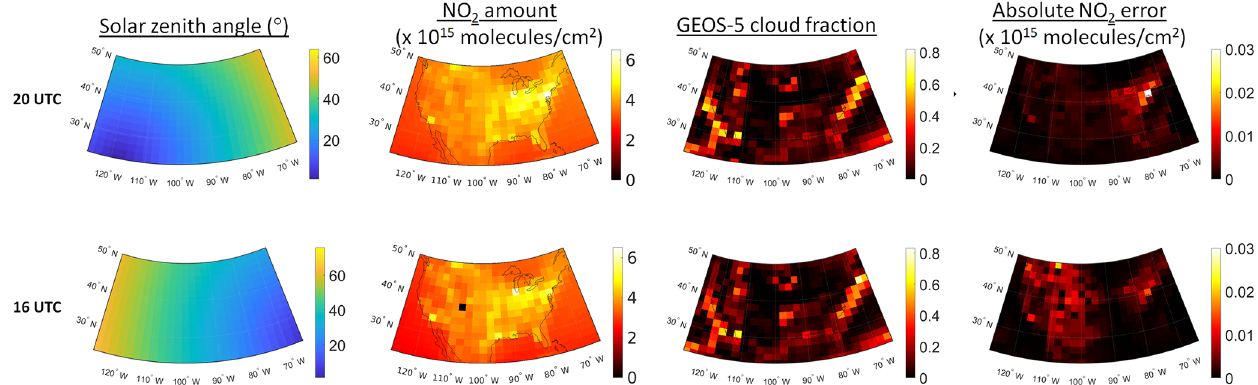
Figure 9. Solar zenith angles, total NO 2 column amount, GOES-5 cloud fraction, and resulting NO 2 errors at 20:00UTC (top) and 16:00UTC (bottom). GEOS-Chem NO 2 profiles were used assuming 5% PS with vertical orientation, all water scenes, and clouds at a 2km altitude (see Table 3, Simulation D for more